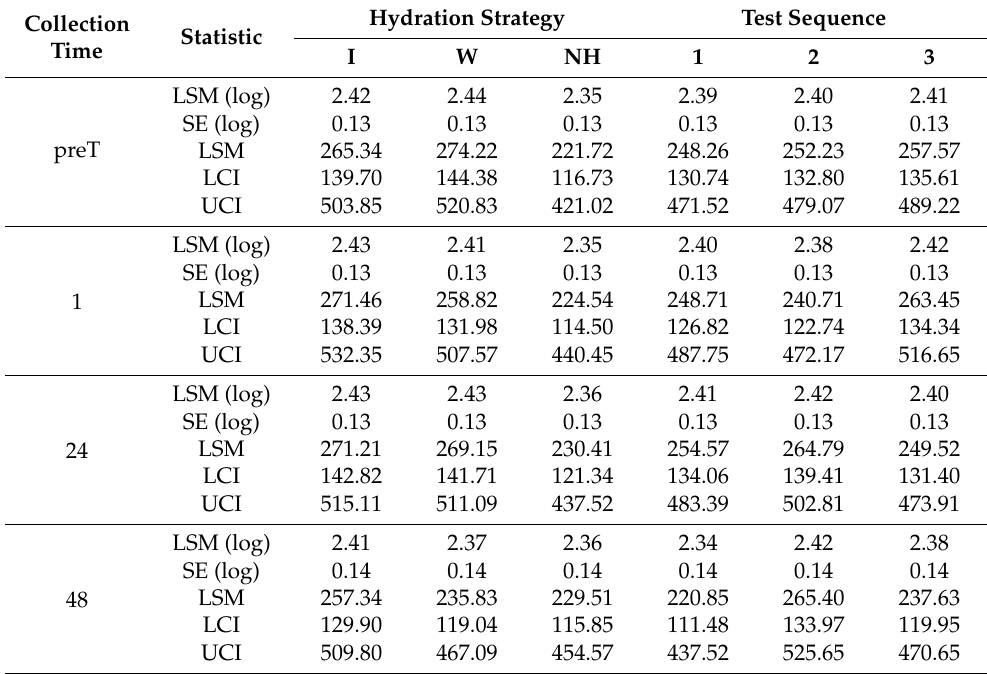
Table 11. Results for lactate dehydrogenase [U · mL − 1] measured before the test (preT) and 1, 24, and 48 h after the test performed for different hydration strategies in three consecutive tests: marginal means (LSM); standard errors (SE) for values after logarithmic transformation (log); and marginal means and upper (UCI) and lower (LCI) confidence intervals restored to original